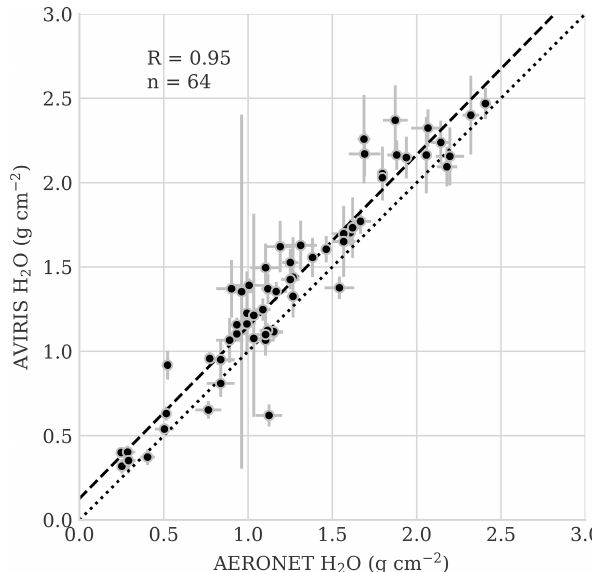
Figure 5. Coincident AVIRIS-C vs. AERONET water vapor mea- surements, filtering out AERONET instances with high temporal variability (1 σ > 0 . 1gcm − 2 over 10 temporally closest measure-